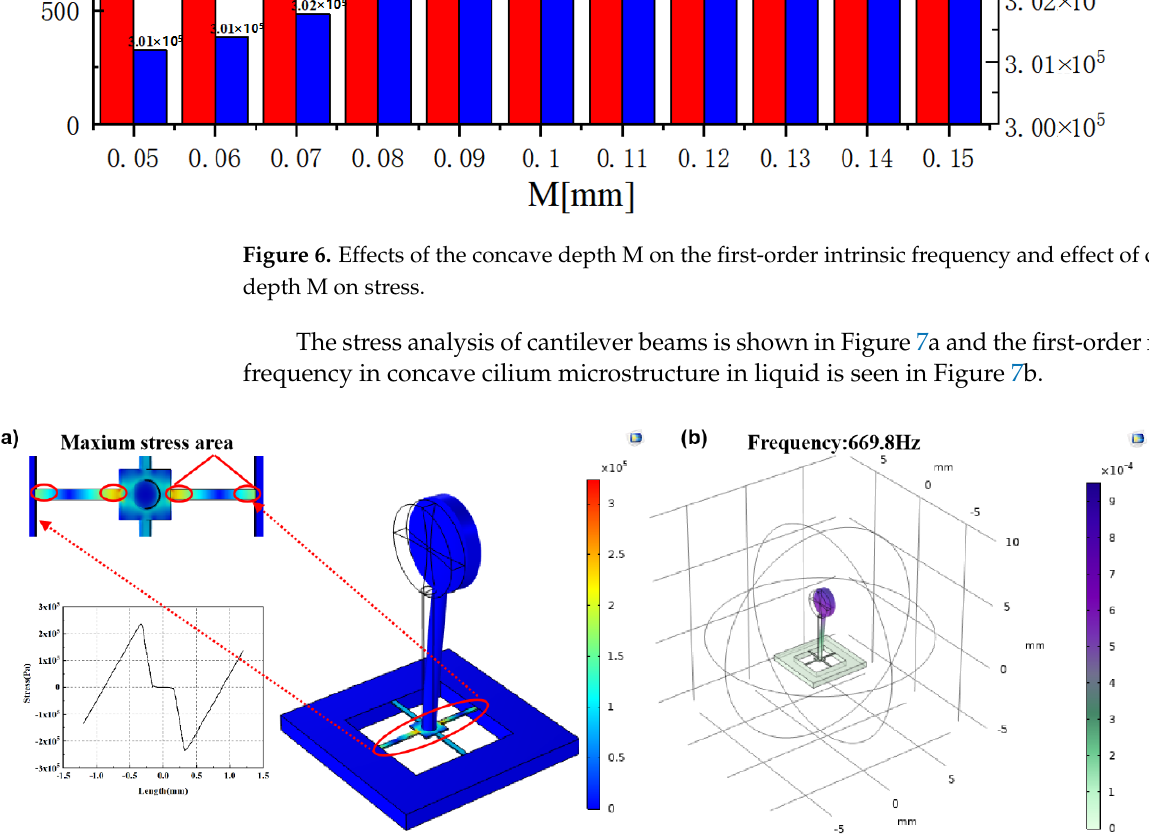
Figure 7. ( a ) Centralized stress simulation of the cantilever beam microstructure. ( b ) First-order natural frequency of concave microstructure.